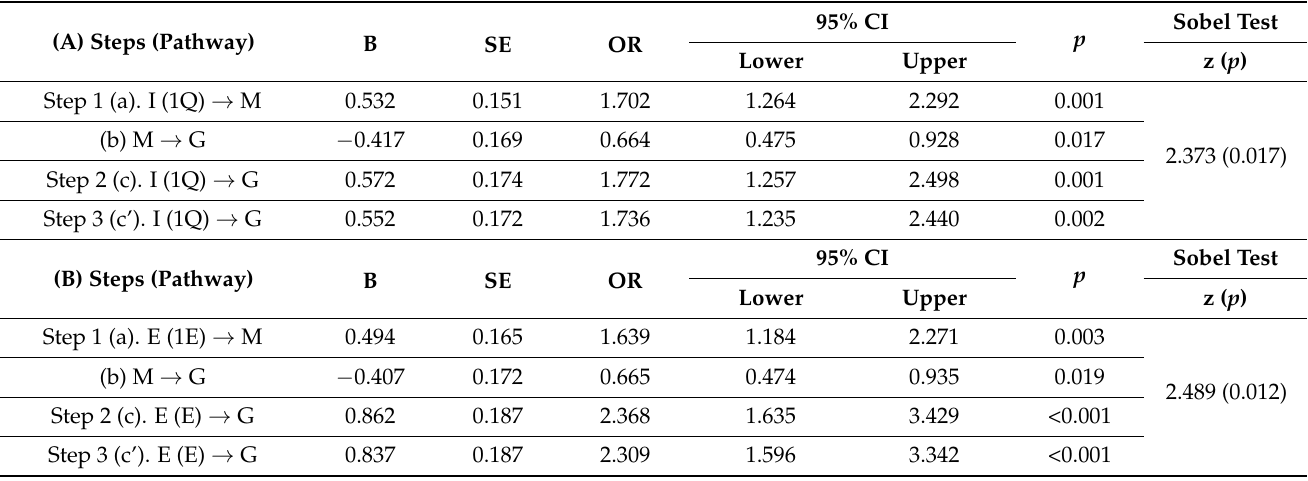
Table 3. Mediating effect of muscle exercise on the association between (A) low household income, (B) low education state, and poor